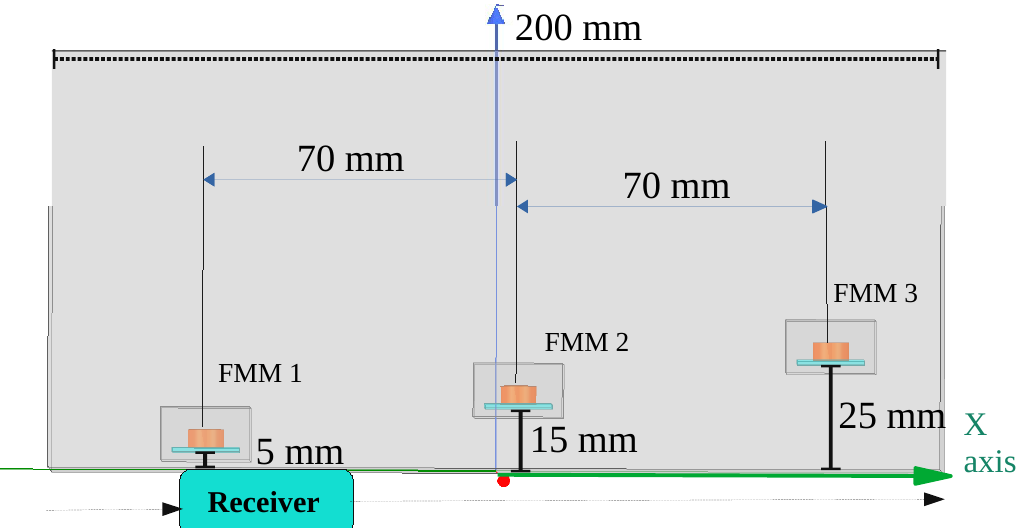
Figure 10. Layout of Configuration